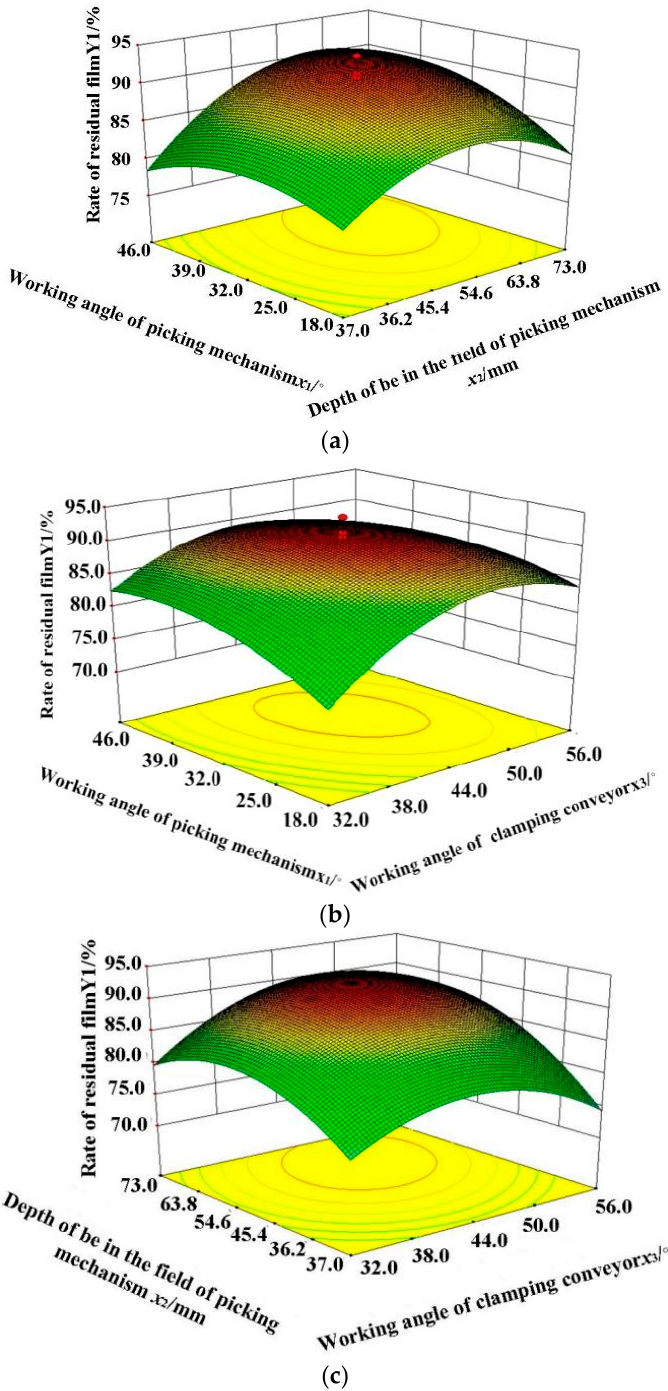
Figure 14. ( a ) The interactive response diagram of the recovery rate is influenced by the working angle and the depth into the soil of the film-picking mechanism. ( b ) The interactive response diagram of the recovery rate is influenced by the working angle of the film-picking mechanism and the working angle of the clamping conveyor mechanism. ( c ) The interactive response diagram of the recovery rate is influenced by the depth into the soil of the film-picking mechanism and the working angle of the clamping conveyor